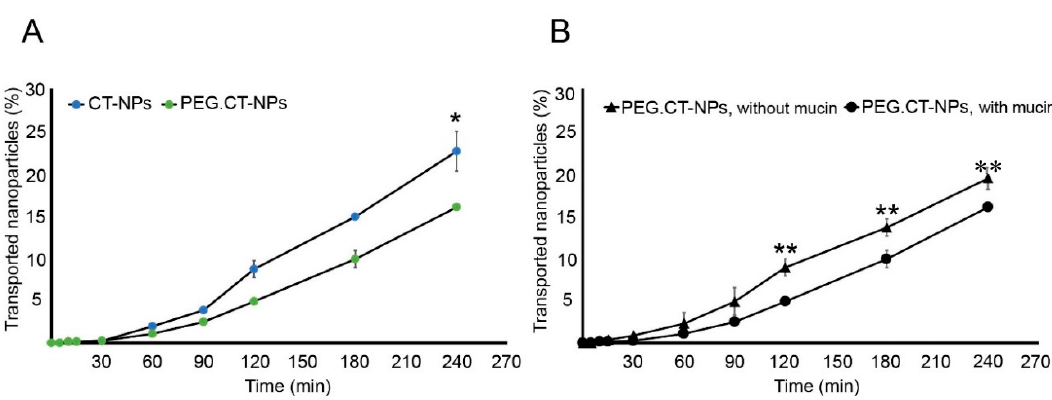
Figure 2. Cumulative transport of ( A ) CT-NPs and PEG.CT-NPs across a co-culture of Caco-2 cells:HT29 (9:1) and ( B ) PEG.CT-NPs across a monolayer of Caco-2 cells and a co-culture of Caco-2HT29 (9:1) cells. Values are expressed as the mean ± S.D. (n = 3). * Statistically significant di ff erence in the transported nanoparticles (%) between non-PEGylated and PEGylated nanoparticles ( p < 0.05); ** Statistically significant di ff erence in the transport of PEGylated nanoparticles between cell monolayers without and with mucin ( p < 0.05).